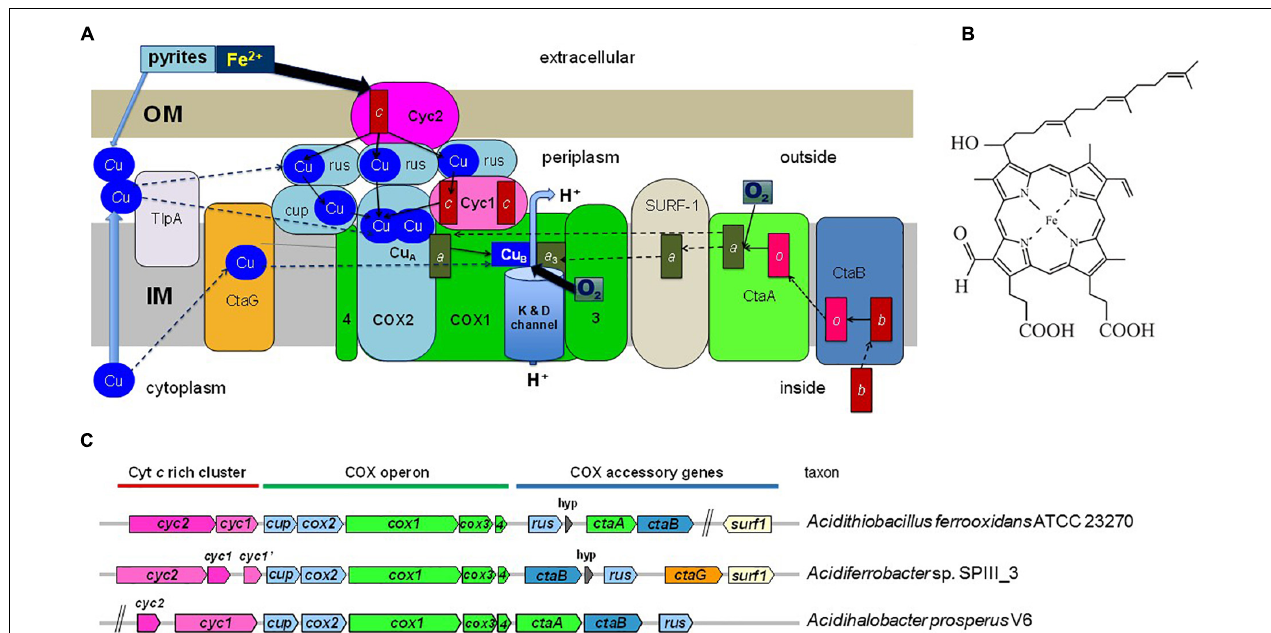
FIGURE 1 | Energy metabolism and COX gene clusters of iron-oxidizing bacteria. (A) The figure illustrates the electron transport system in the cytoplasmic membrane of iron-oxidizing bacteria and proteins that function in COX biogenesis. The two heme A molecules in the COX1 subunit are indicated by dark green rectangles labeled a and a 3 . COX2 and other Cu-binding proteins are colored in pale blue, while proteins containing c -type cytochromes (heme C is indicated by the red rectangle) are in dark pink. COX3 and COX4 are abbreviated as 3 and 4, respectively, and are colored in bright green as subunit COX1. OM and IM indicate the outer and inner (cytoplasmic) membrane of the bacterium. Rusticyanin (rus) is shown in multiple copies because it is present in large excess with respect to the other redox proteins of the system (Blake et al., 2016). Cup refers to membrane-bound cupredoxin proteins (Degli Esposti, 2020). TlpA stands for thioredoxin-like protein A, a membrane-bound protein involved in Cu A assembly. Thin arrows indicate electron transfer routes while dashed arrows indicate steps in COX biogenesis. The water enzyme product of COX is not shown. The overall scheme of electron transfer from extracellular donors to oxygen reduced in the cytoplasmic membrane applies to a variety of bacteria that have multiheme c cytochromes instead of rusticyanin mediators (Deng et al., 2018). (B) Structure of heme A. The difference of this variant of heme compared to heme B (protoheme IX) is the hydroxyethyl-farnesyl group and the formyl group. (C) Gene clusters for COX in bacteria often contain genes for heme A synthesis ( ctaA, ctaB ) and COX assembly ( ctaG, surf1 ), as illustrated by representative gene clusters of iron-oxidizing Proteobacterial taxa. The size of the gene symbols is roughly proportional to gene length. hyp, gene for a short hypothetical